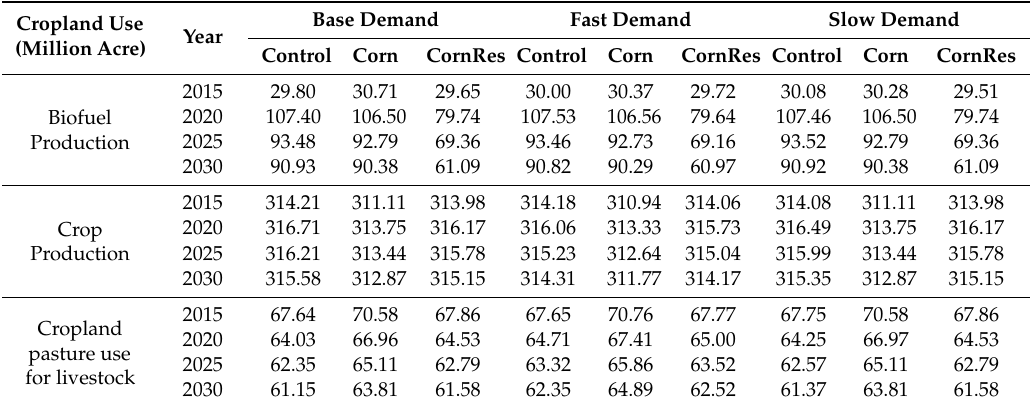
Table 4. Average U.S. cropland use during 2015 to 2030 under various biofuel policy and demand growth